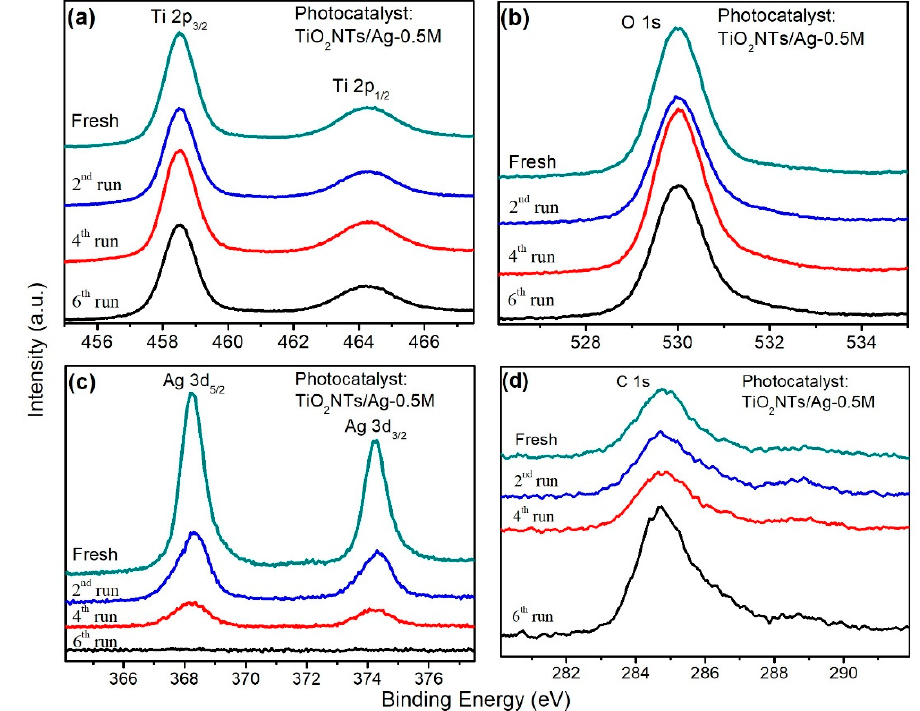
Figure 8. Fine-scan XPS spectra of ( a ) Ti 2p, ( b ) O 1s, ( c ) Ag 3d and ( d ) C 1s taken from fresh and recycled TiO 2 NTs/Ag-0.5 M photocatalyst.